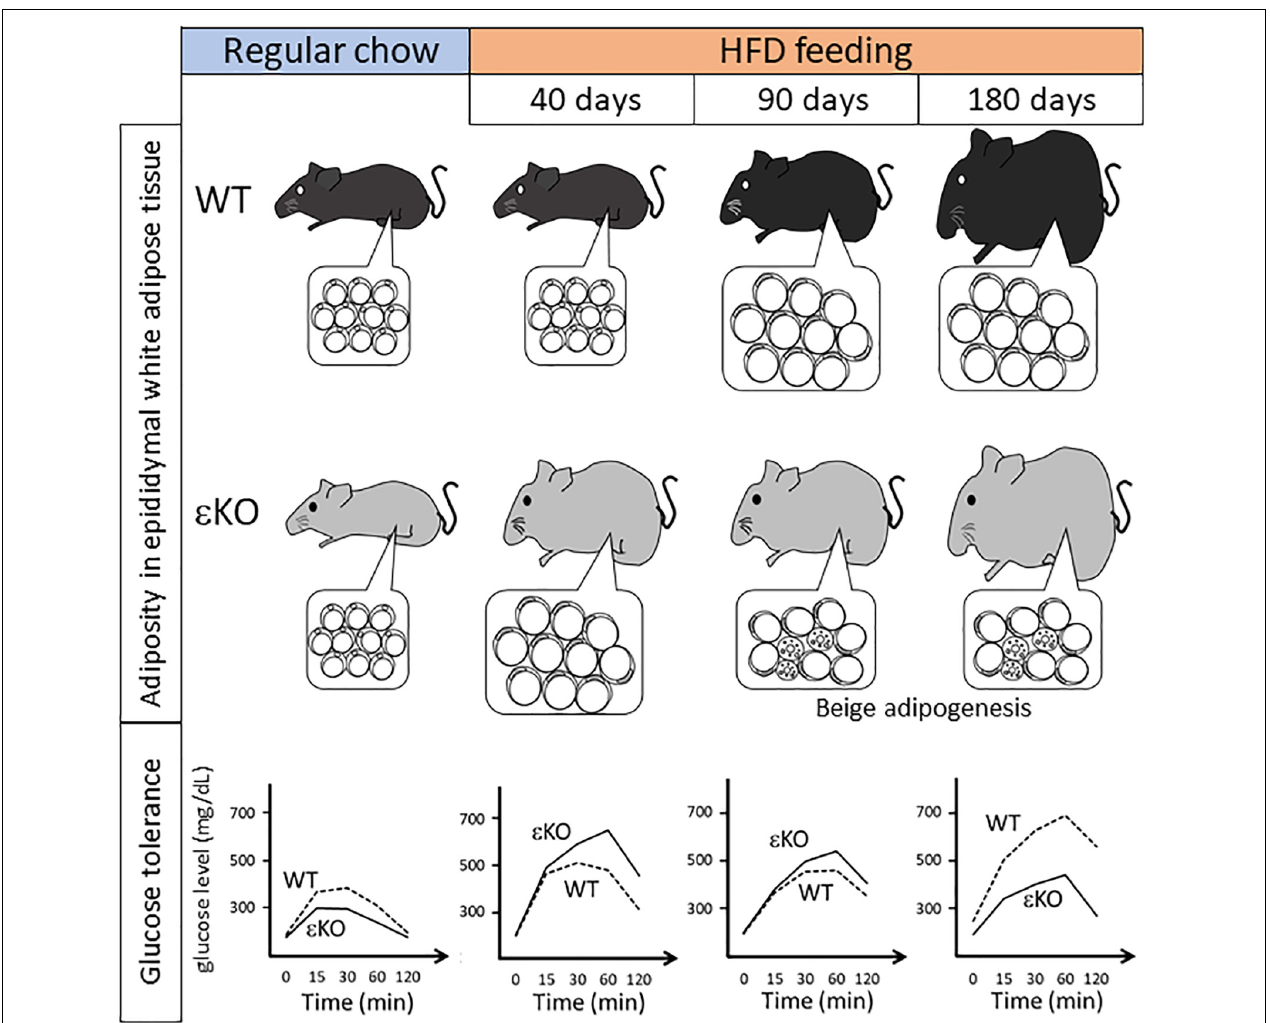
FIGURE 2 | Summary of phenotypical alteration of DGK ε -KO mice during the course of HFD feeding regimen. Pathophysiological alterations in body weight, adiposity in epididymal white adipose tissue (insets), and glucose tolerance are shown during the course of HFD feeding (Nakano et al., 2018, 2020). Note that in DGK ε -KO mice under long-term HFD feeding beige adipogenesis as shown by multilocular cells is induced, which coincides with improved glucose tolerance. HFD, high fat diet; ε KO, DGK ε -KO mice; WT, wild-type mice.